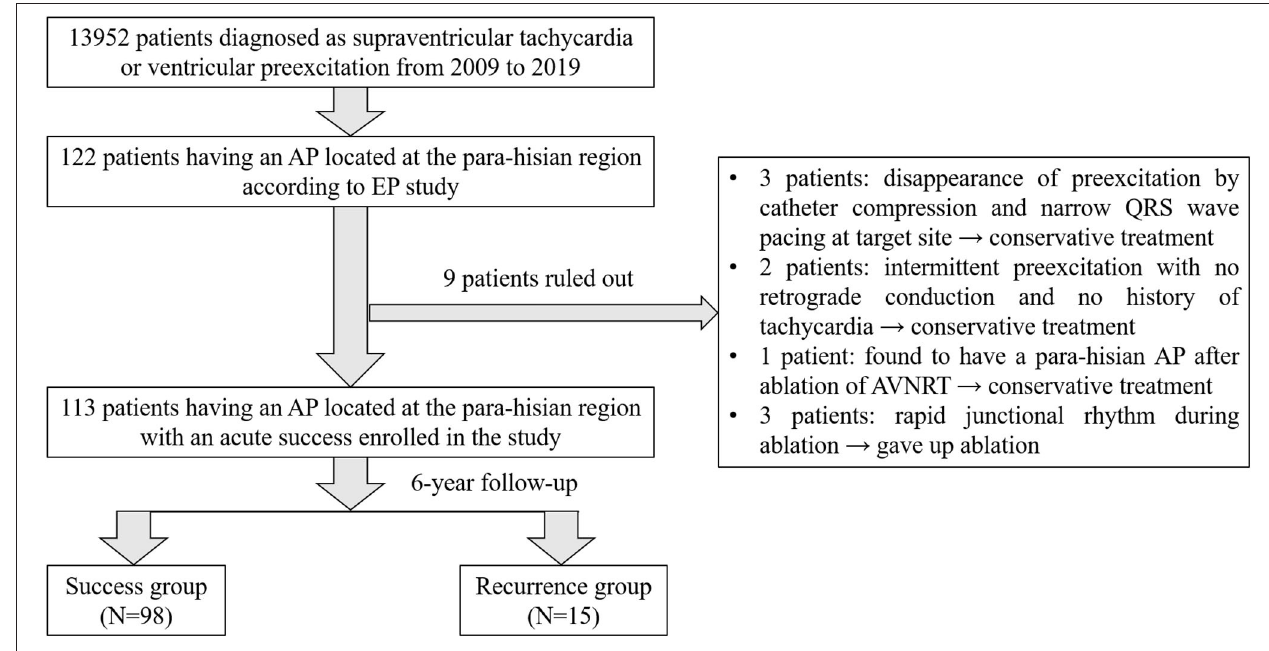
FIGURE 1 | Flowchart of patient